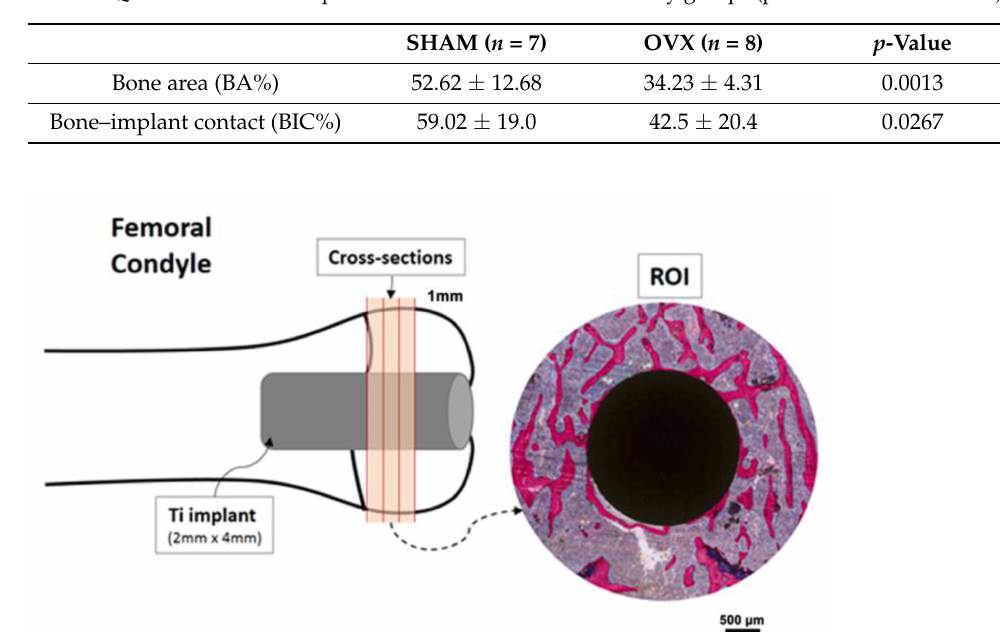
Table 1. Quantitative histomorphometric variables for the two study groups (presented as mean ± SD).